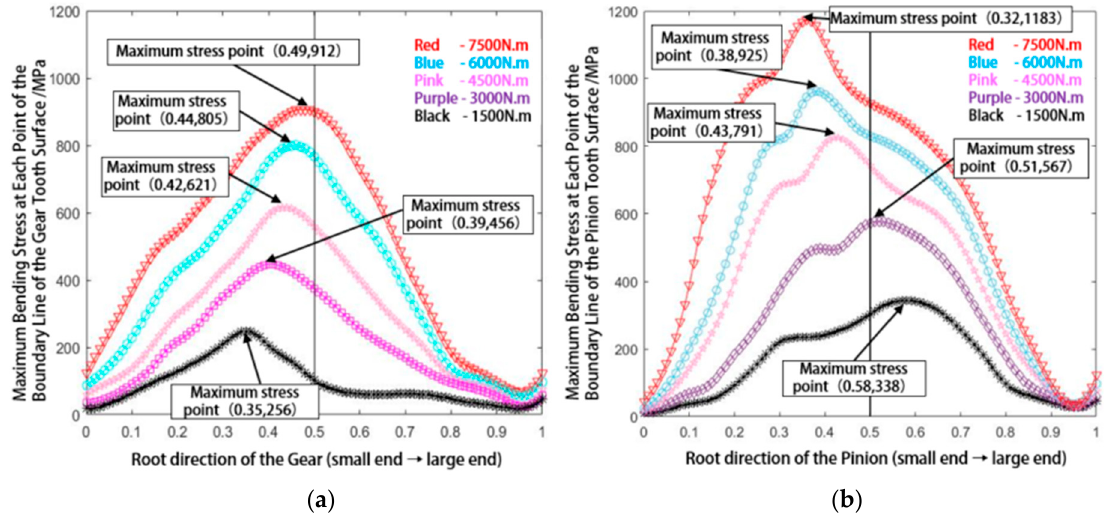
Figure 13. Comparison of the maximum value of bending stresses on the tooth surface boundary: ( a ) maximum bending stresses value of gear, and ( b ) maximum bending stresses value of pinion.